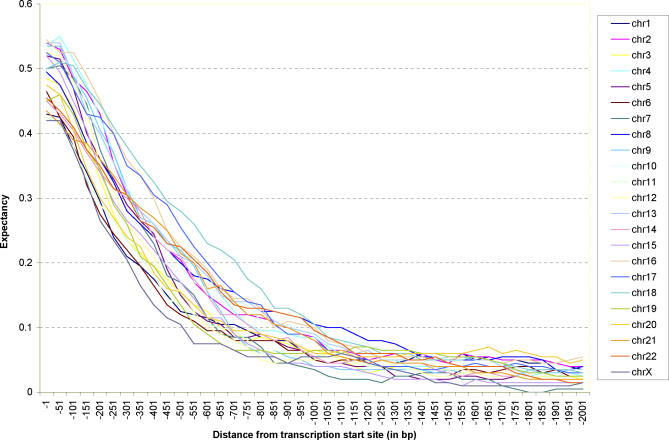
CpG Island Positional BiasCpG island expectancy is plotted for each chromosome as a function of the distance from the TSS. This type of data was used to normalize many of the features in this study for distance from the TSS. In this figure, the expectancy of being in a CpG island at position −1 for any promoter region is ~0.5.